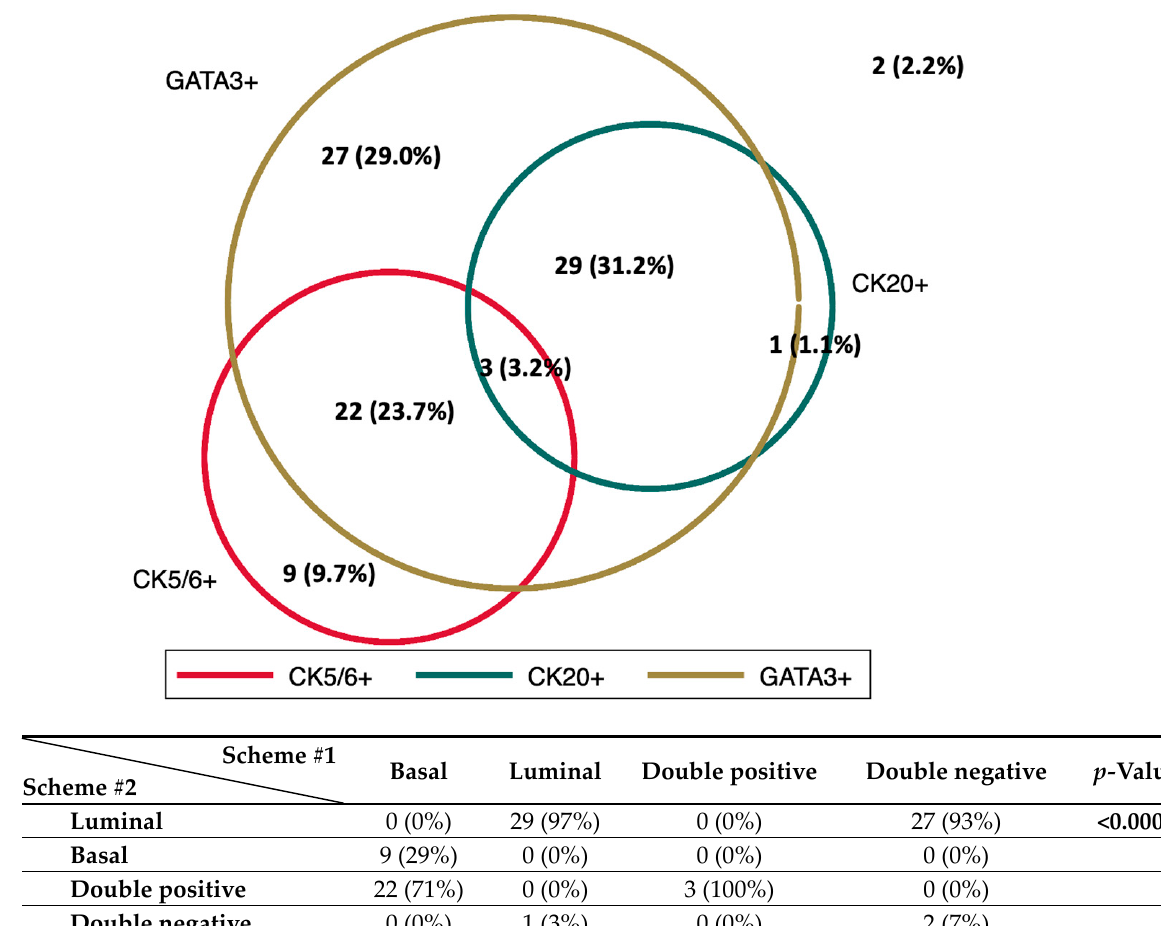
Figure 1. Venn diagram showing the expression of the 1 basal (CK5/6) and 2 luminal (CK20, GATA3) markers analyzed in this study. The relationships between the two schemes are summarized in the contingency